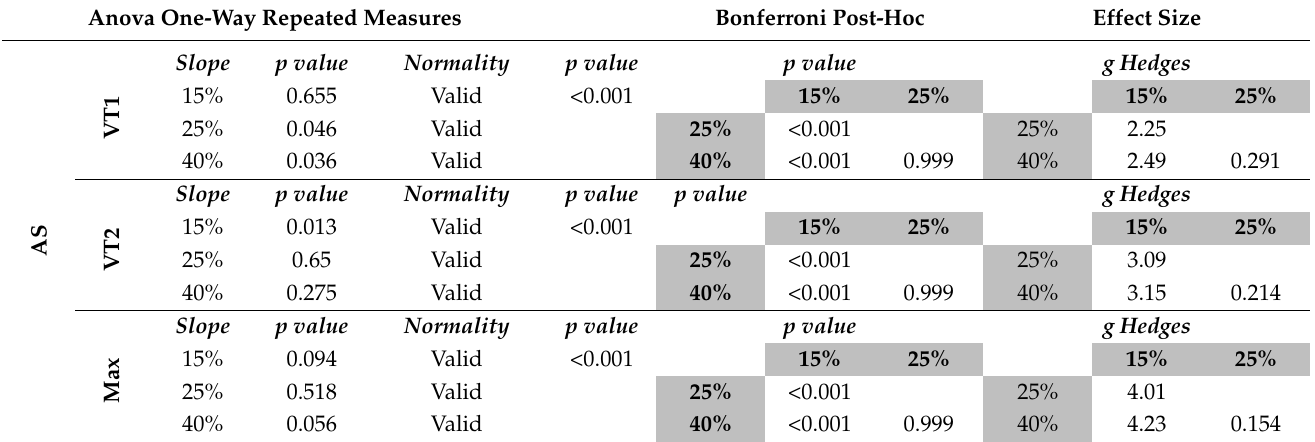
Table 3. Results of statistical analysis including Shapiro–Wilk test for normality and p value for one-way ANOVA and Bonferroni post-hoc analysis comparing ascending speed (AS) at all positions (VT1, VT2 and MAX) and between slope conditions 15, 25 and 40%. Effect sizes are presented in right part of the table using Hedges’ g